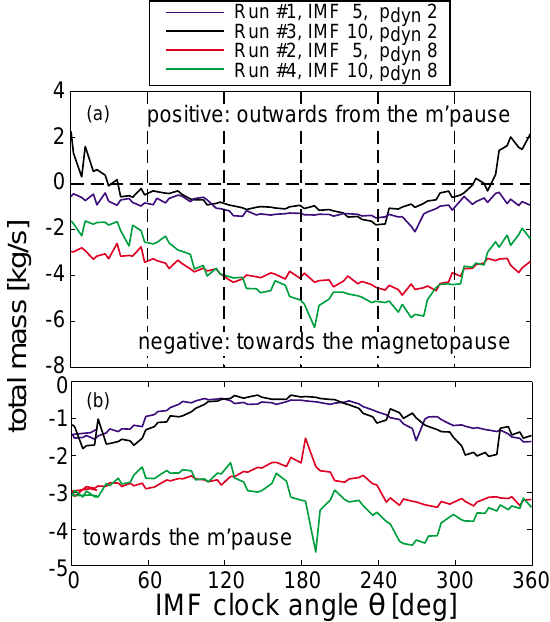
Fig. 5. Total transferred mass through (a) the entire magnetopause between subsolar position and − 30 R E , and (b) sunward of the ter- minator as a function of clock angle (and time) in the four runs.